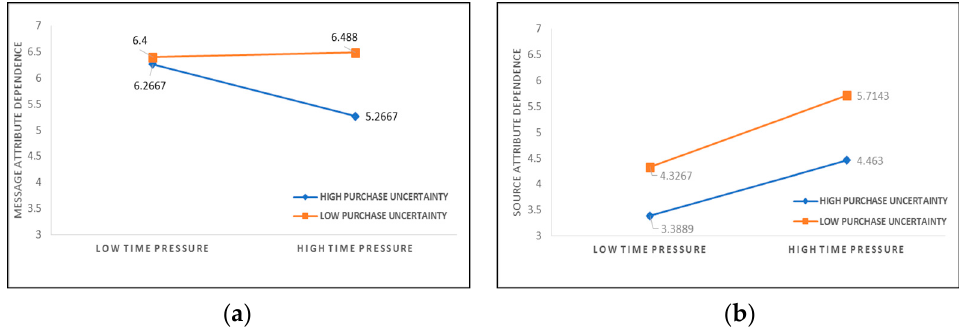
Figure 3. The interaction effect of perceived time pressure and perceived purchase uncertainty. ( a ) Message attribute dependence, ( b ) Source attribute